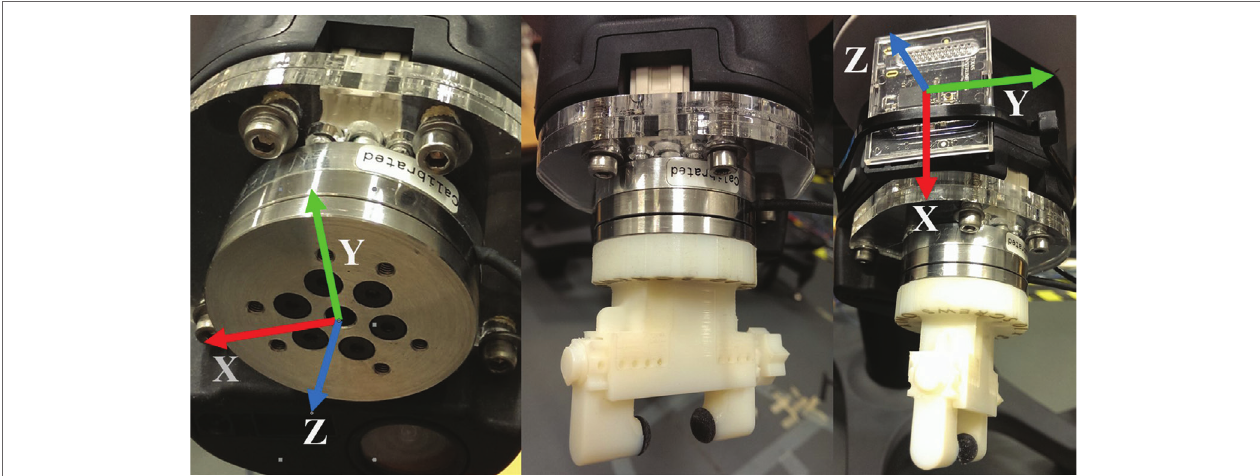
FigUre 6 | showing (left) modified end effector of the Baxter robot with a plastic interface part allowing mounting of the 6-axis force/torque sensor with axes definition, (middle) 3D printed, thumb-turn operated clothing clamp mounted to the sensor, and (right) location of wireless iMU with axes